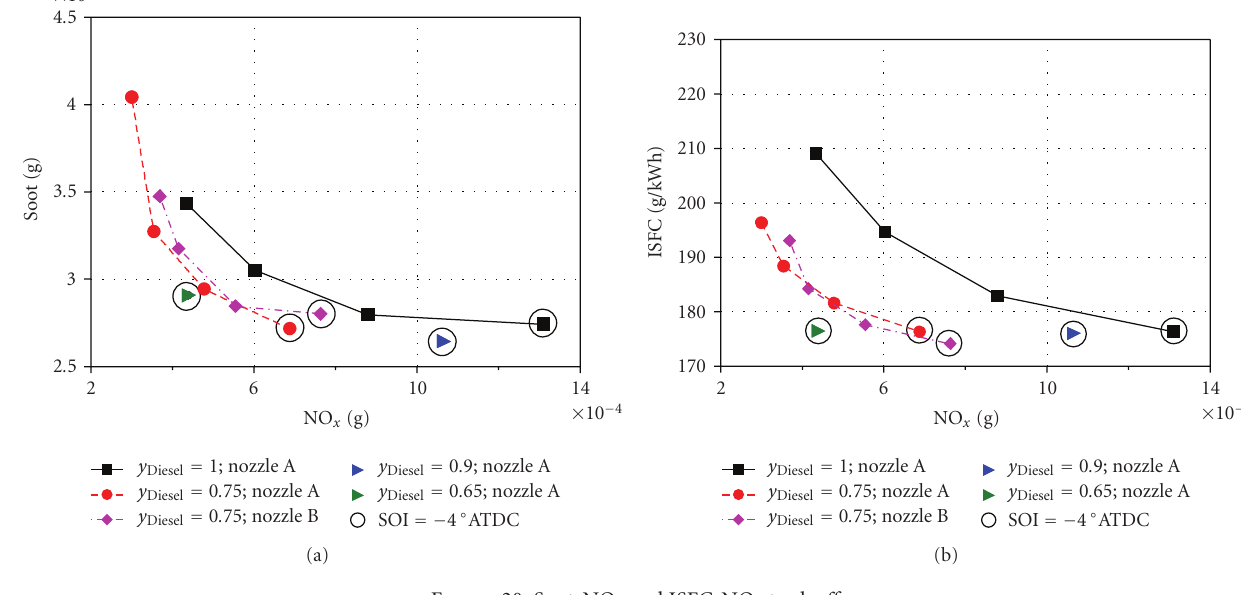
Figure 20: Soot-NO x and ISFC-NO x tradeo ff